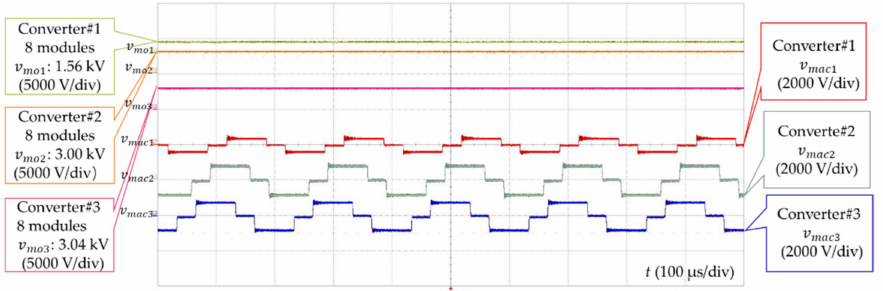
Figure 28. Modules waveform under different irradiance.